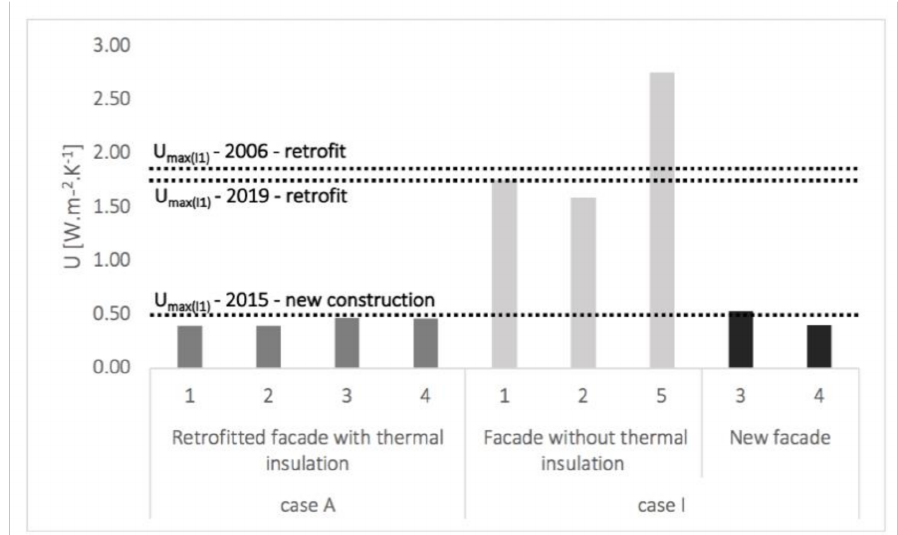
Figure 6. Comparison between the values of the thermal transmittance (U) of each constructive solution of the façades from case studies A and I, and the maximum values allowed by thermal regulations for climate zone I1, through the